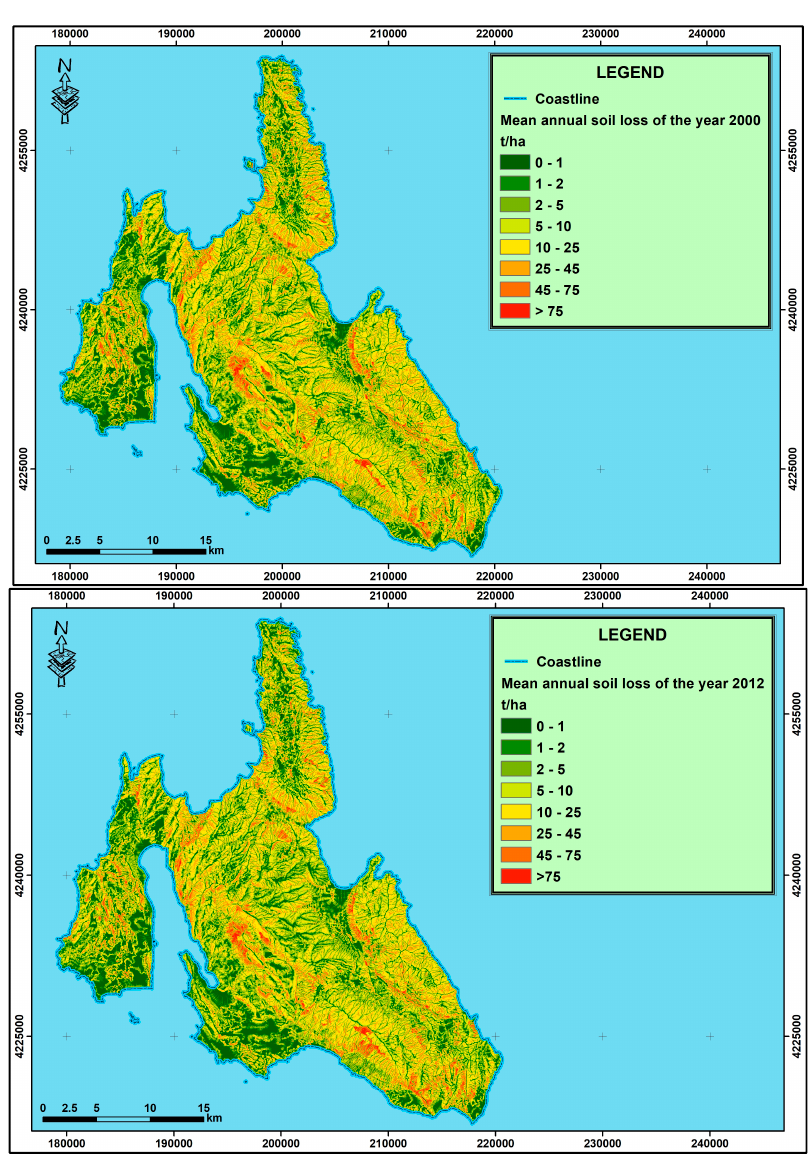
Figure 3. Soil loss ( Α ) map of Cephalonia Island in the years 2000 ( above ) and 2012 ( below